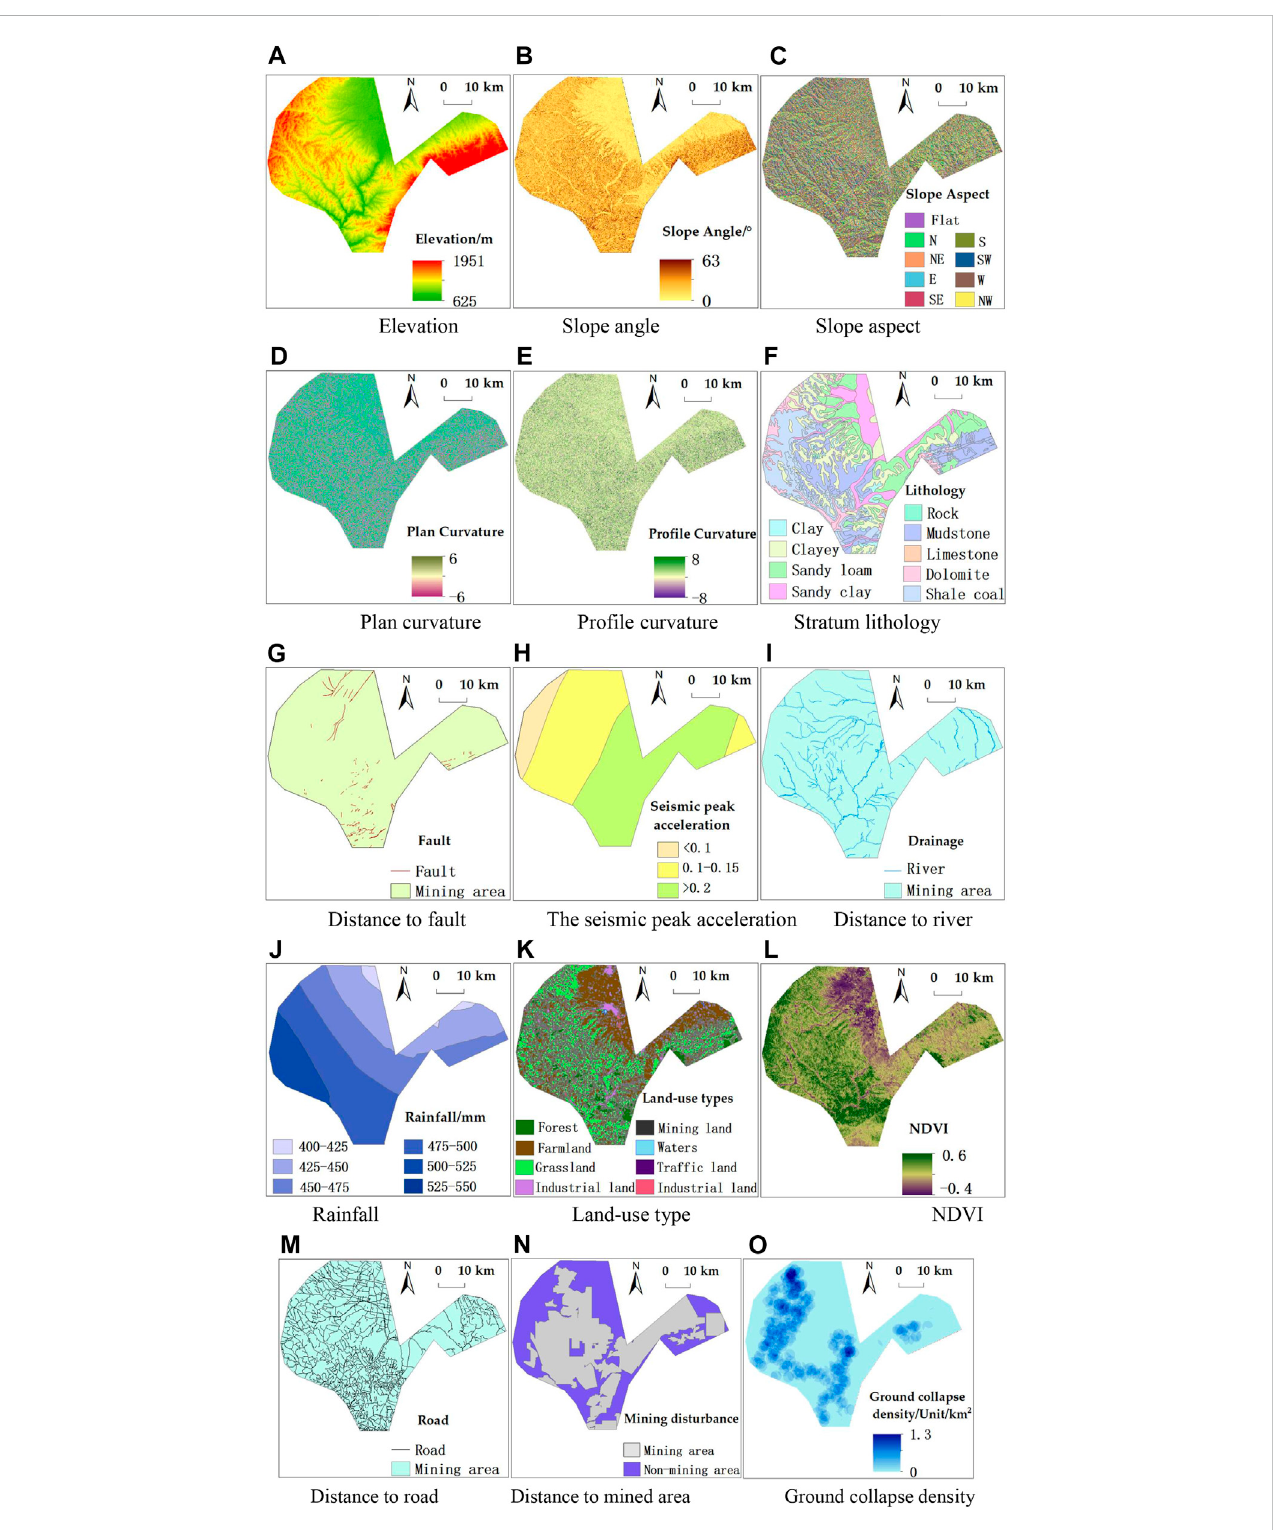
FIGURE 2 Landslide condition factors of the Fenxi coal mine. (A) Elevation, (B) Slope angle, (C) Slope aspect, (D) Plan curvature, (E) Pro fi le curvature, (F) Stratum lithology, (G) Distance to fault, (H) The seismic peak acceleration, (I) Distance to river, (J) Rainfall, (K) Land-use type, (L) NDVI, (M) Distance to road, (N) Distance to mined area, (O) Ground collapse